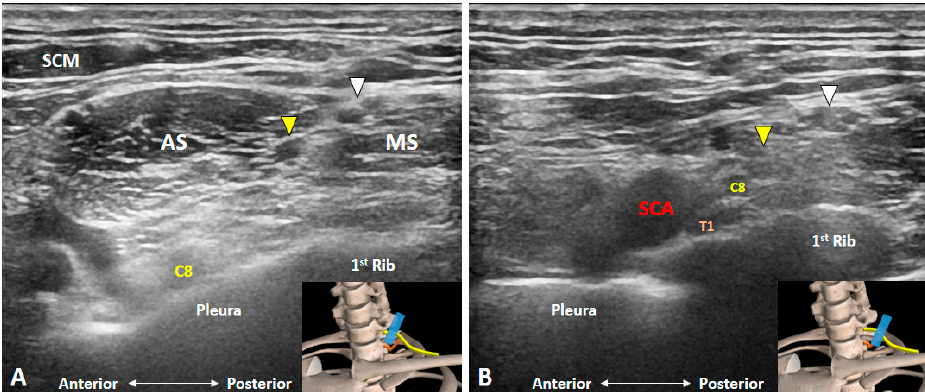
Figure 5. Ultrasound imaging of the C8 and T1 anterior rami. The C8 anterior ramus ( A ) is seen on top of the pleura at the bottom of the inter-scalene groove. T1 anterior ramus ( B ) can be visualized distal and lateral to the inter-scalene groove, emerging from the undersurface of the first rib. AS: anterior scalene muscle; MS: middle scalene muscle; SCA: subclavian artery; SCM: sternocleidomastoid muscle. White arrowheads: superior trunk; Yellow arrowheads: middle trunk. The blue rectangles at the bottom-right corners represent the transducer position.